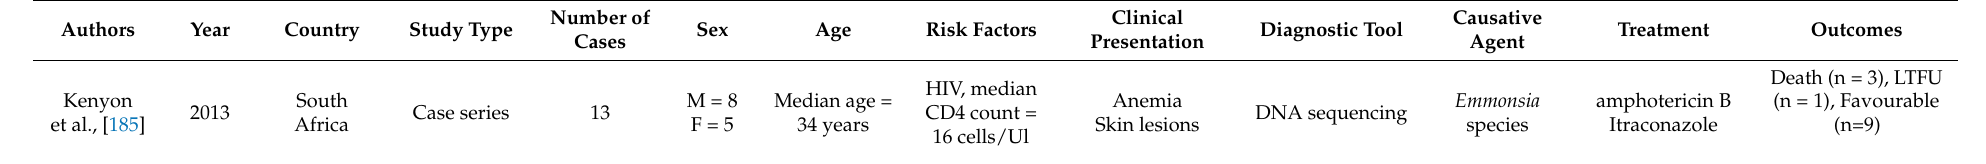
Table 8. Studies published on emergomycosis in